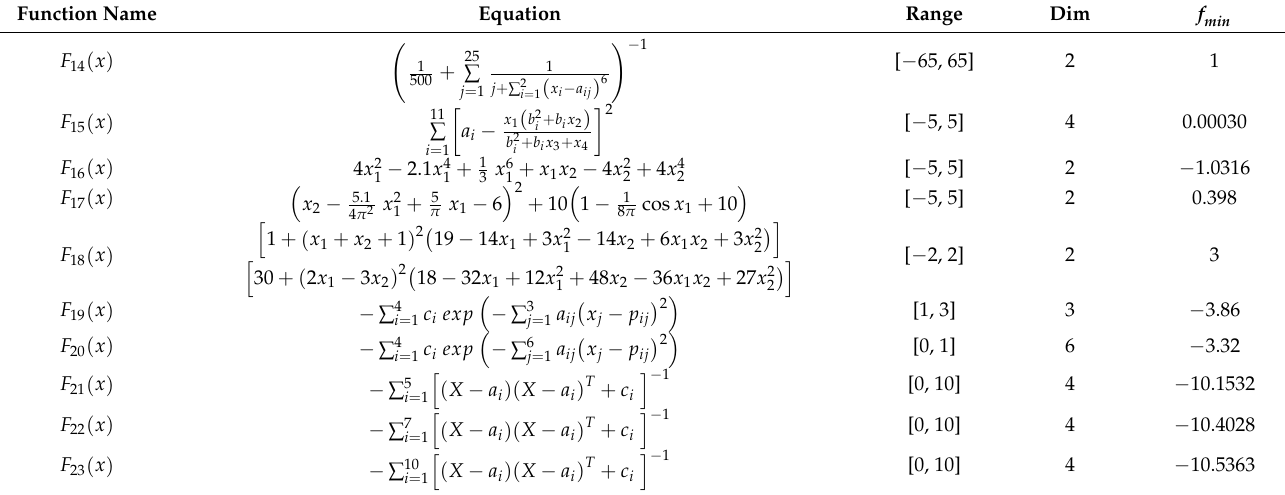
Table 4. Fixed dimensional benchmark function